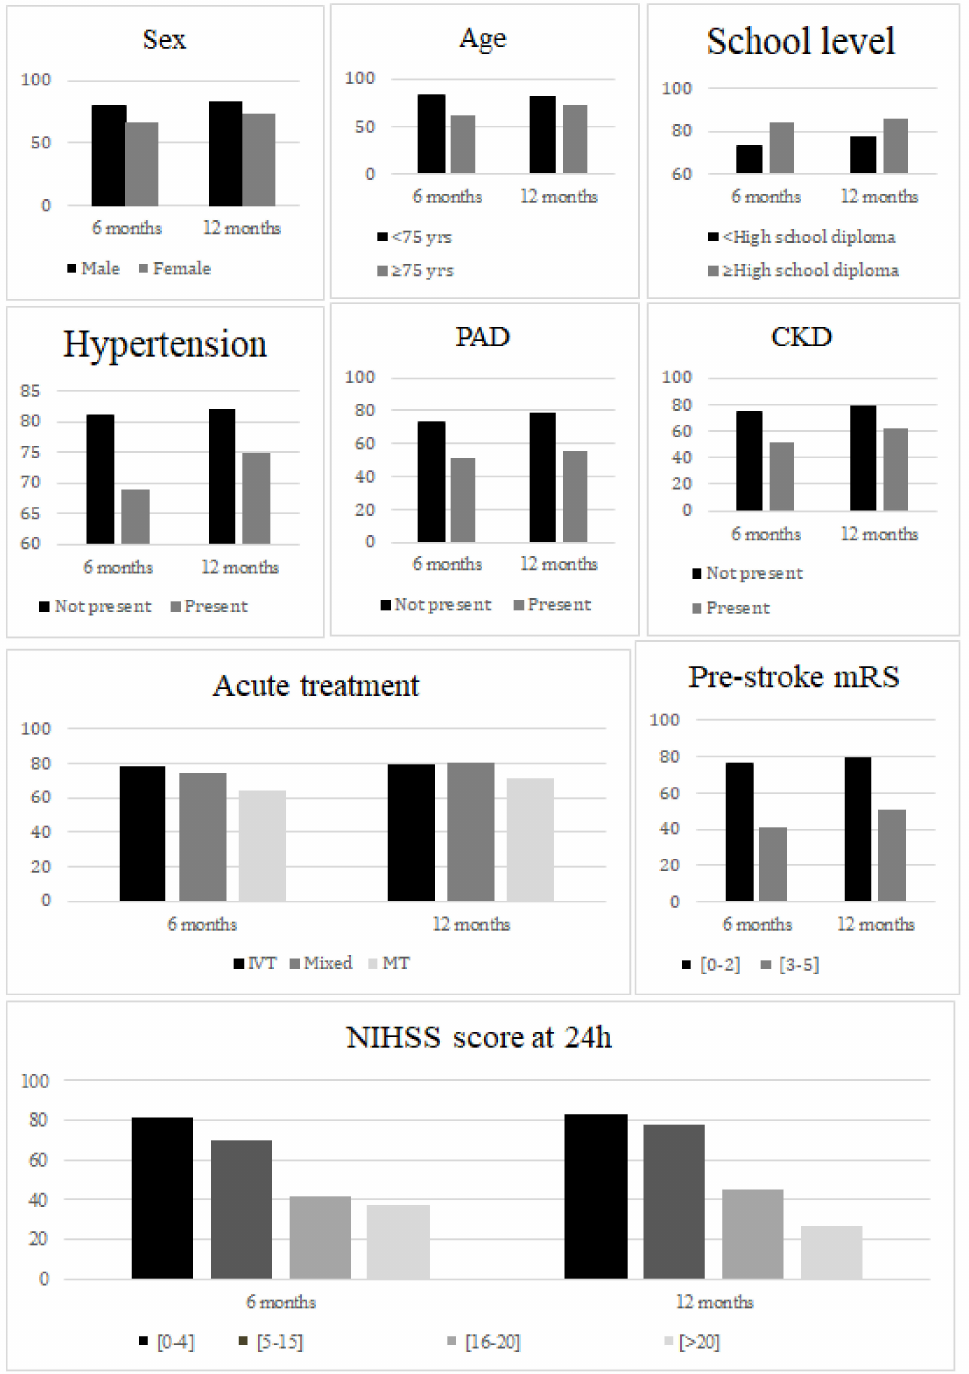
Figure 3. Mean mobility score at 6 months and 12 months according to patients’ characteristics. PAD, peripheral artery disease; CKD, chronic kidney disease